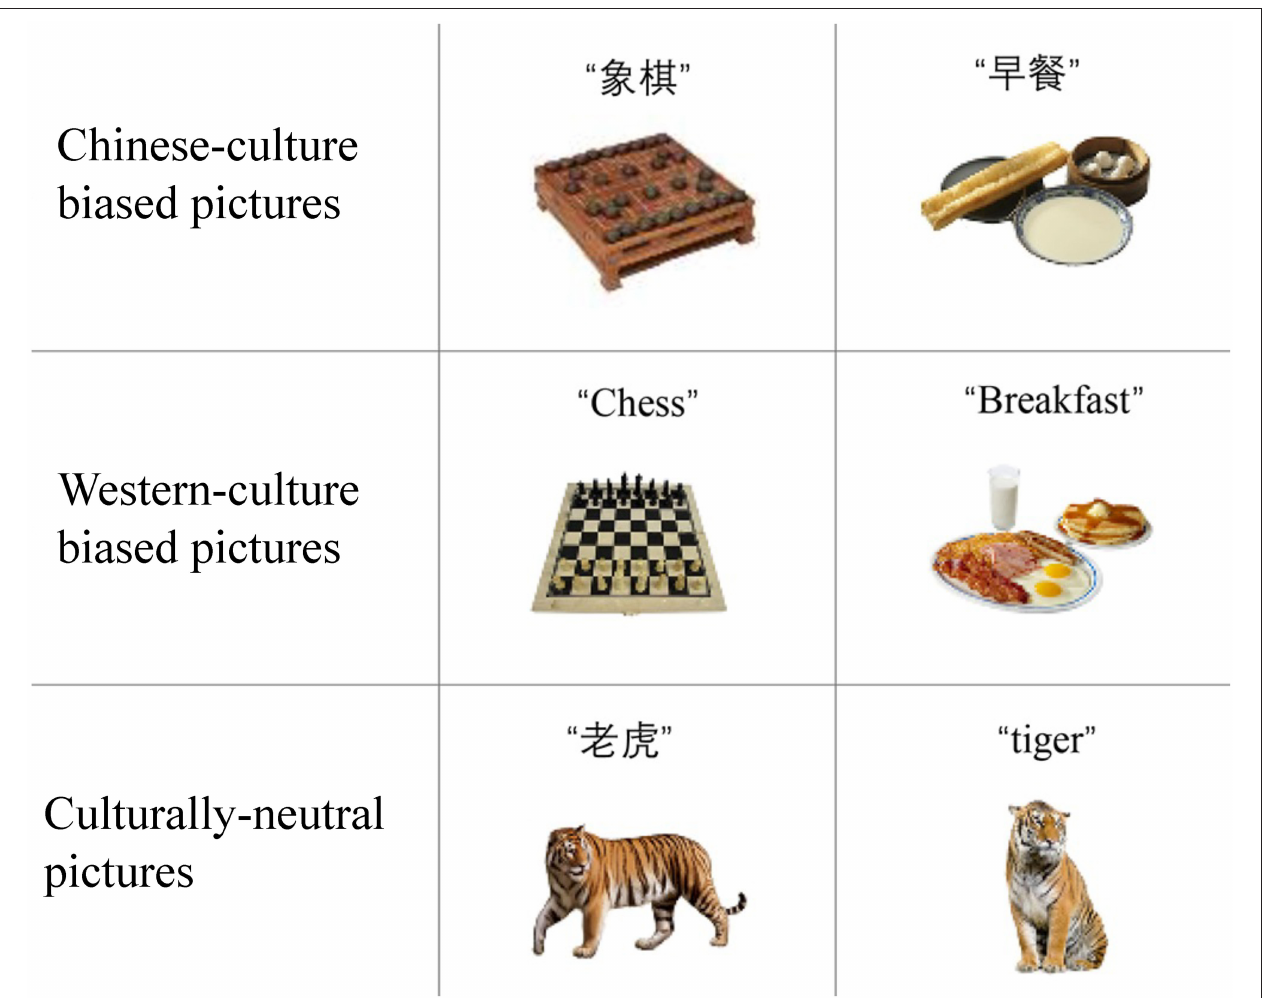
FIGURE 1 | Sample pictures. There is a one-to-one correspondence between Chinese-biased pictures and western-biased pictures. For example, “ 早 餐 ” in Chinese and “Breakfast” in English indicate the same object. To match the biased pictures, there are two pictures indicating the same object for culturally-neutral pictures as